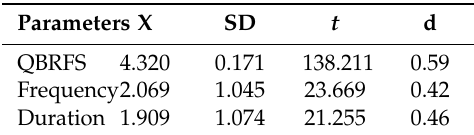
Descriptive analyze of QBRFS and duration of practicing figure skating during recreational time.